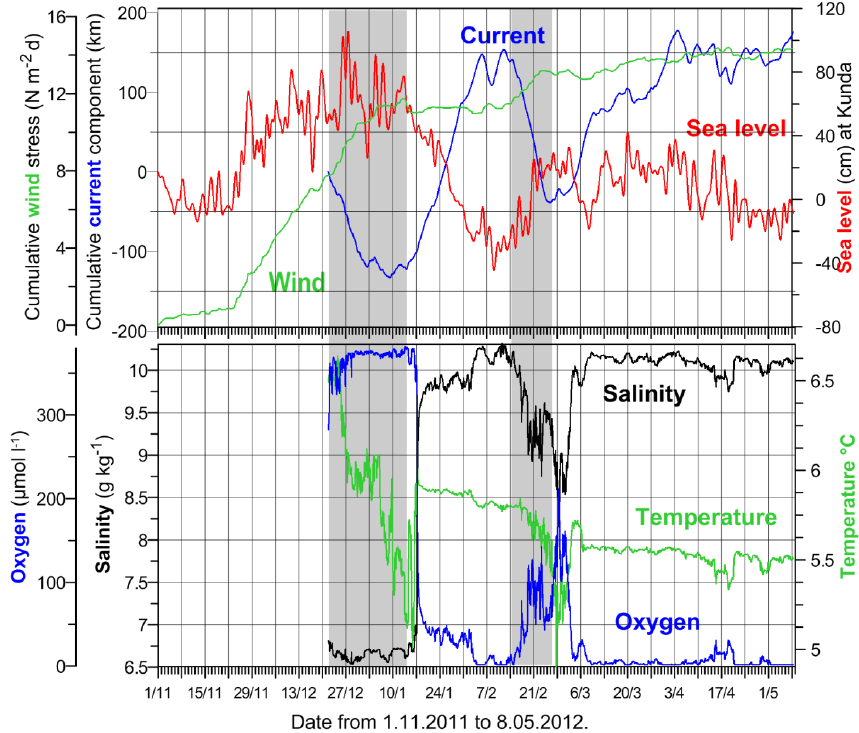
Figure 6. Cumulative along-gulf axis current velocity component (km, blue line), cumulative wind stress (Nm − 2 d, green line) and low-pass filtered sea level (cm) time series in the upper panel. Hourly time series of salinity (gkg − 1 , black line), temperature ( ◦ C, green line) and dissolved oxygen (µmolL − 1 , blue line) in the lower panel. Temperature, salinity, dissolved oxygen and current were measured at location A3 from 21 December 2011 to 8 May 2012 at a depth of 85m (approximately 5m above the seafloor). Wind and sea level measurements were obtained at Tallinnamadal Lighthouse and Kunda coastal station, respectively. Shaded areas mark time intervals when estuarine circulation reversals prevailed.